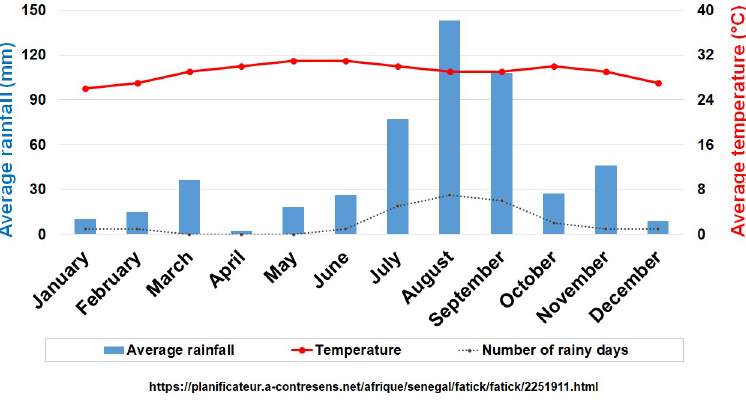
Fig 2. Average monthly temperature and rainfall data in the Fatick region,